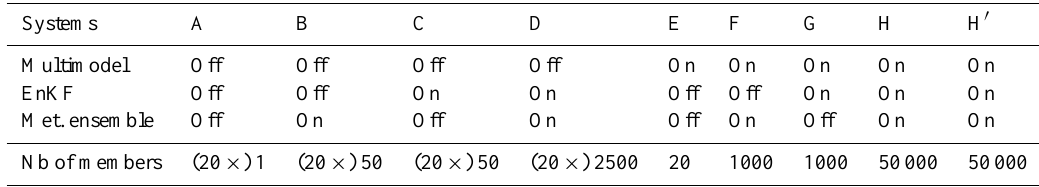
Table 3. Description of the nine forecasting systems.